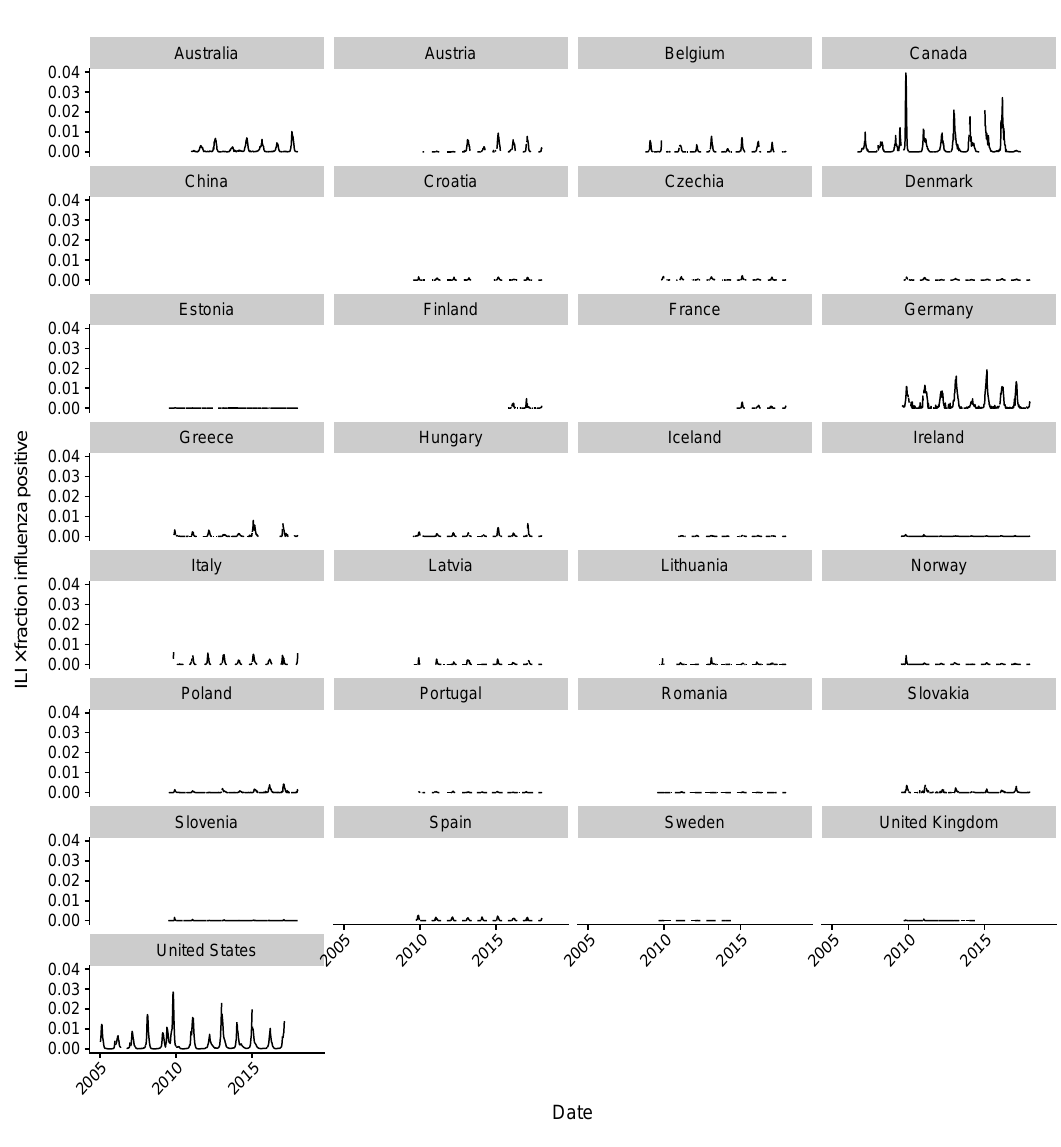
Figure A20. As in Figure A9, but using a fixed y -axis scale for